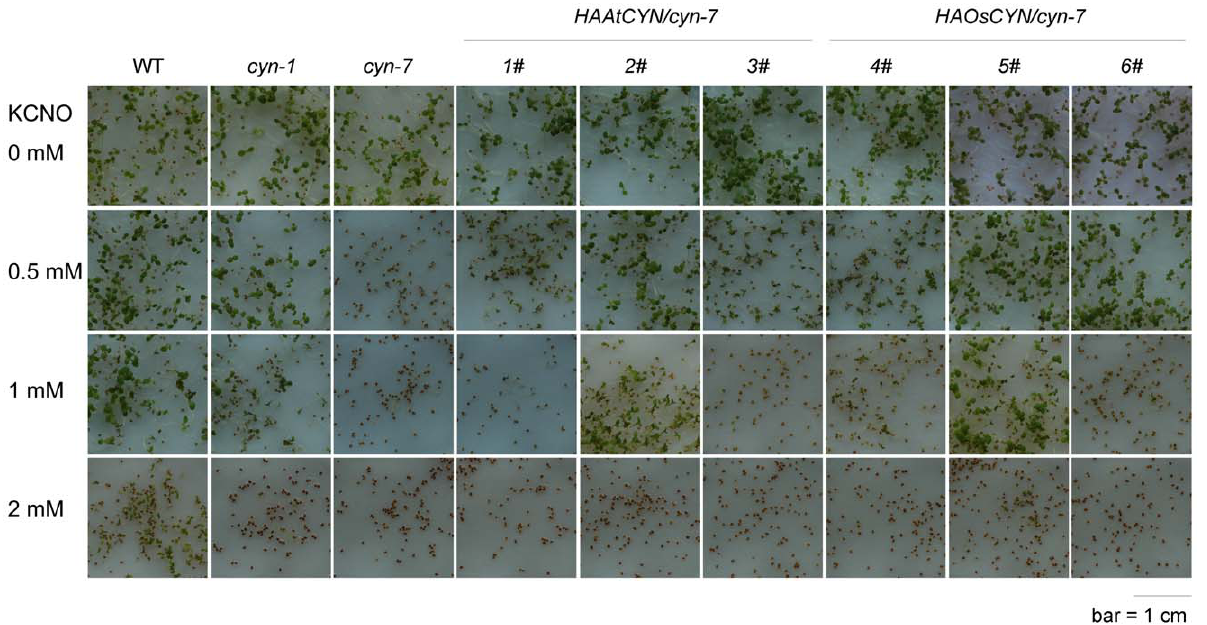
Figure 5. Decomposition of cyanate by AtCYN and OsCYN invivo . Seeds were plated on MS medium containing either 0 mM, 0.5 mM, 1 mM or 2 mM KCNO. Plates were incubated at 4 u C for 3 days and then transferred to a growth chamber for 7 days.